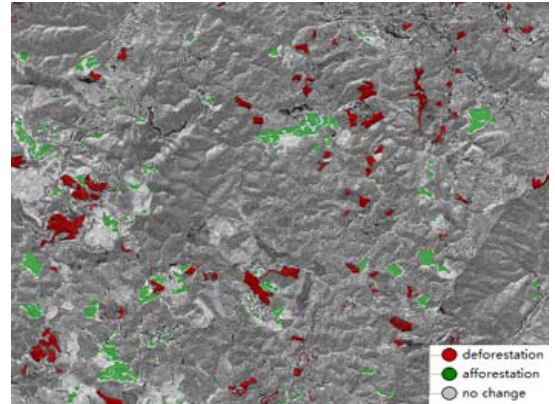
Fig.4 Forest cover change map